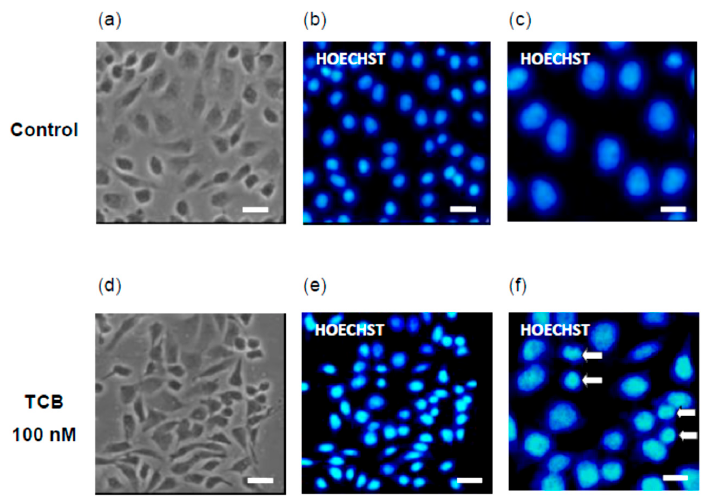
Figure 7. Apoptotic morphology of LLC-PK1 cells treated with telocinobufagin (TCB). Serum-starved LLC-PK1 cells were treated with 100 nM TCB in 2.5% FBS for 24 h. Phase-contrast microscopy ( a : control; d : TCB) and Hoechst 33,342 staining for nuclear fluorescence ( b , c : control; e , f , TCB). Higher magnification is shown in ( c , f ). Arrows indicate cells with pyknotic nuclei in ( f ). Scale bar: 50 µ m ( a , b , d , e ); 20 µ m ( c , f ).